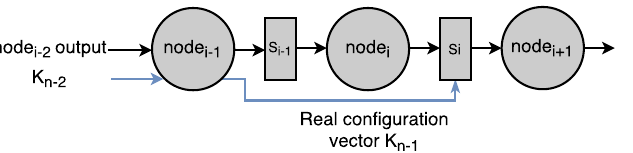
Figure 2. Encrypting random configuration logic using existing IPN nodes. K j is the configuration vector encrypted by a chain of nodes from node 1 to node j